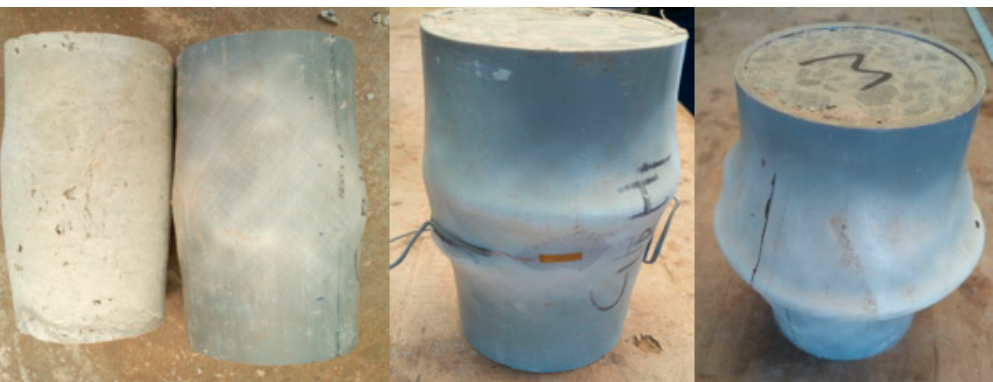
Figure 8. Drum Type Failure.